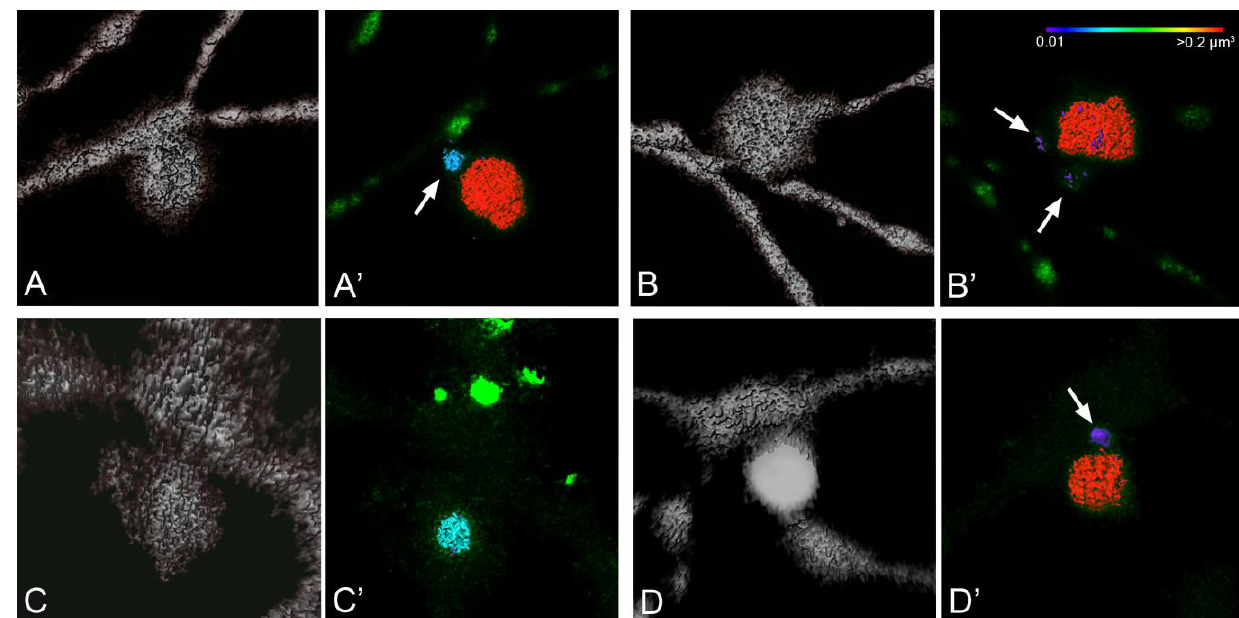
Figure 5. Mitochondrial density in the arbors of a single ON-OFF RGC. Masked out ON and OFF arbors of a single cell showing the distribution of CFP-labeled mitochondria in each (Imaris rendering). The inset shows each arbor (and cell soma with the ON arbor) with the tdTomato cell fill label included. The OFF arbor is larger and more complex, but appears to have a lower density of mitochondria compared to the ON arbor. Scale Bar = 50 µm.